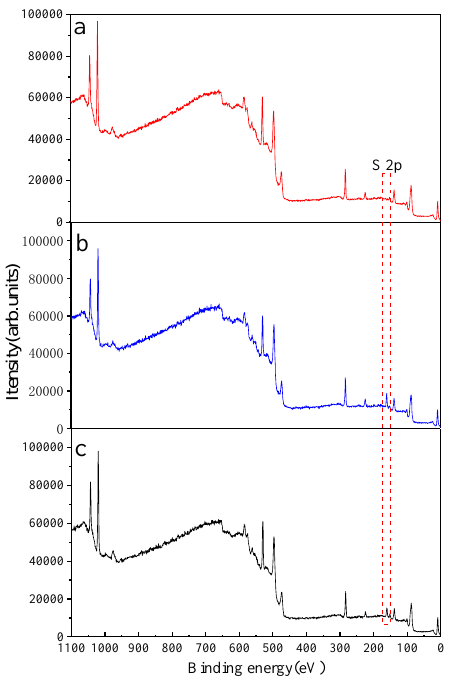
Figure 7. XPS survey spectra of hemimorphite treated with ( a ) deionized water, ( b ) 5 mM Na 2 S ( c ) 5 mM Na 2 S + 1mM Fe 3 +